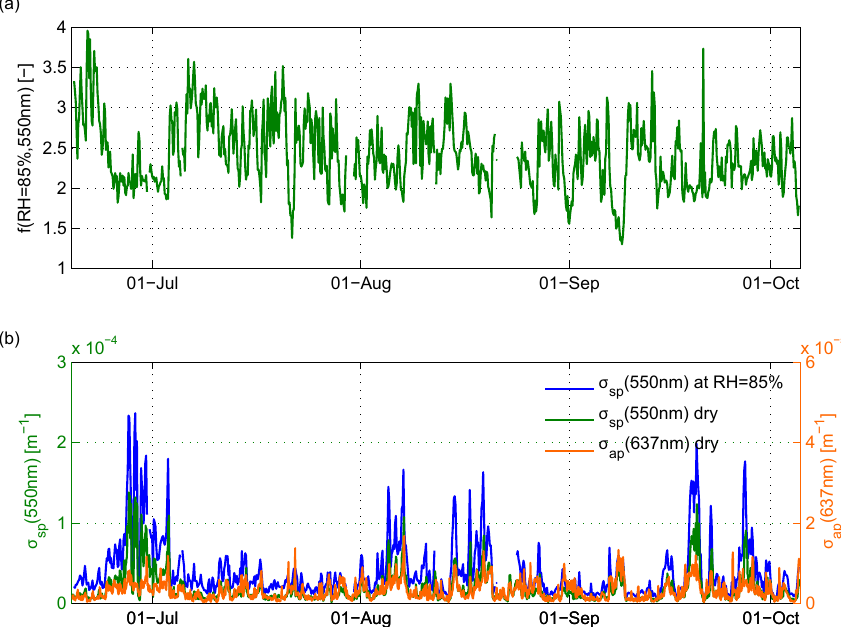
Fig. 1. Panel (a) Time series of the scattering enhancement factor f (RH=85%, 550nm) measured at Cabauw, The Netherlands, over the period from mid June to the beginning of October 2009. Panel (b) Scattering coefficient at λ = 550nm at RH=85% (blue line) and at dry conditions (green line) measured by the humidified nephelometer (WetNeph) and reference nephelometer (DryNeph). The absorption coefficient at λ = 637nm (orange line) was measured by the multi-angle absorption photometer (MAAP) at dry